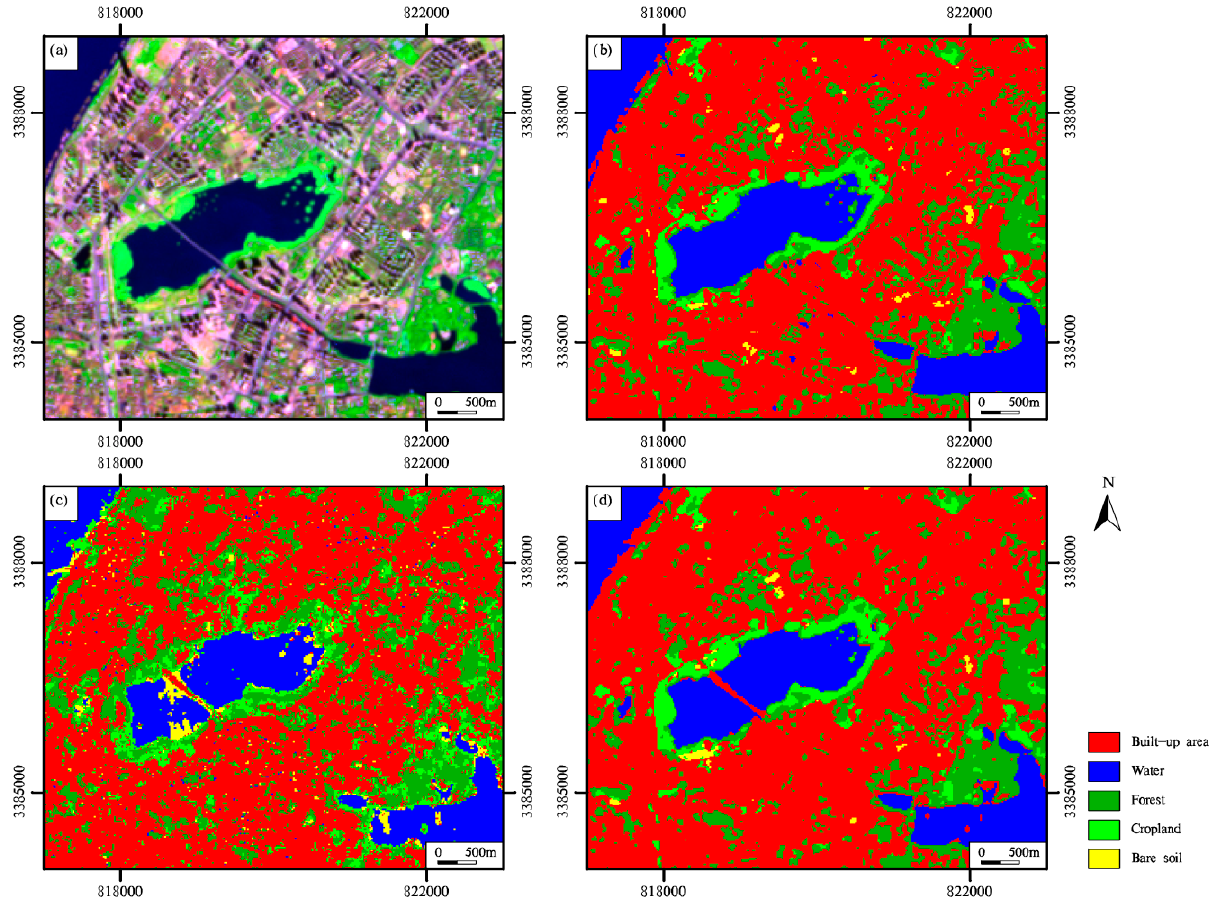
Figure 11. ( a ) False-color composite (red, band 12; green, band 8a; blue, band 2) Sentinel-2B MSI image in Area 2. Land cover map obtained from the SVM-CK algorithm with the Sentinel-2B MSI image ( b ), the Sentinel-1A SAR image ( c ), and the combination of Sentinel-2B MSI and Sentinel-1A SAR data ( d ).